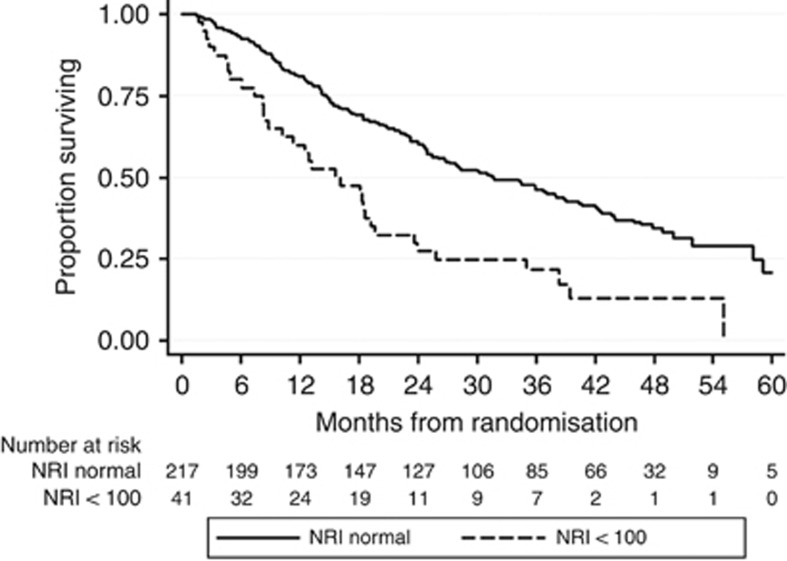
Kaplan-Meier curve of overall survival according to baseline NRI score (log-rank P-value <0.001). Abbreviation: NRI, nutritional risk index.